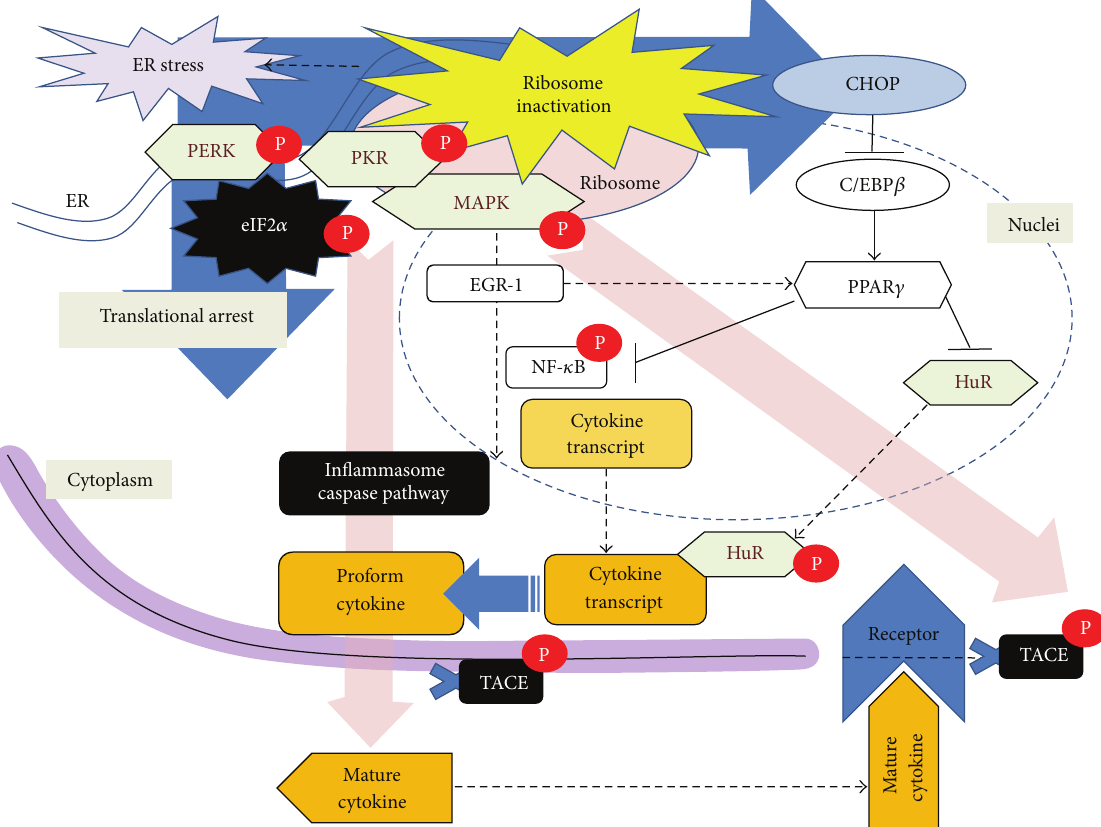
Figure 1: A putative diagram of ribosomal stress-derived signaling networks for cytokine